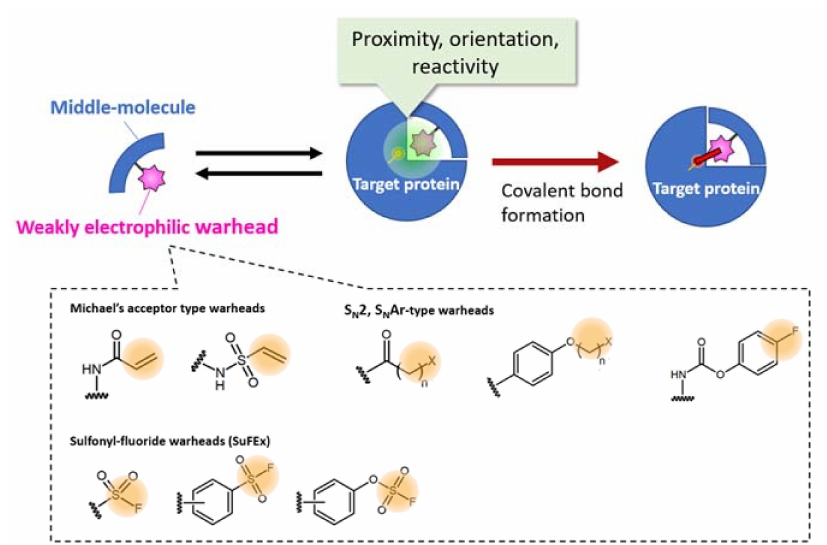
Figure 3. Selected examples of warheads for creating a bioTCI. For the appropriate covalent bond formation, both proximity, orientation, and optimized reactivity between the warhead and a nu- cleophilic amino acid of the target protein are needed. For a comprehensive classification of the warheads, see [16,40]. Synthetic strategies of SuFEx-type warheads, summarized in the latest review by am Ende and Ball’s group [41] is very